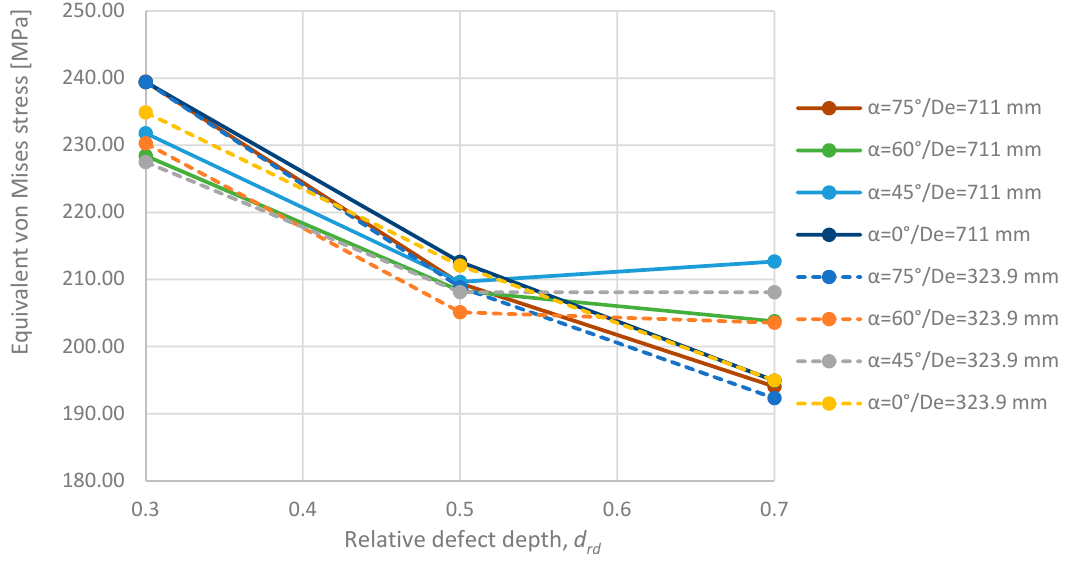
Figure 14. Equivalent Von Mises stress maxima for both steel pipes and type III composite.